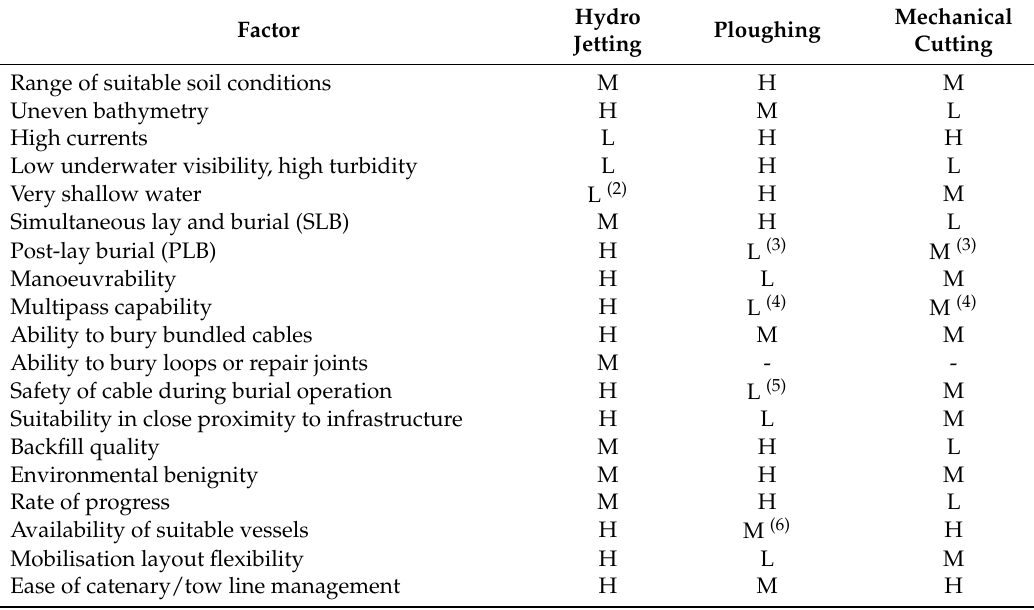
Table 2. Comparison of Burial Techniques [25] (for the assessment see (1) ). Hydro